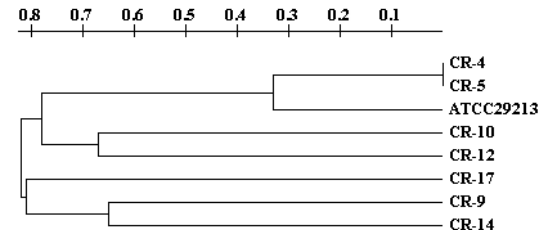
Figure 1. Genetic Relationship Observed by MLVA among Sta- phylococcus aureus Isolates